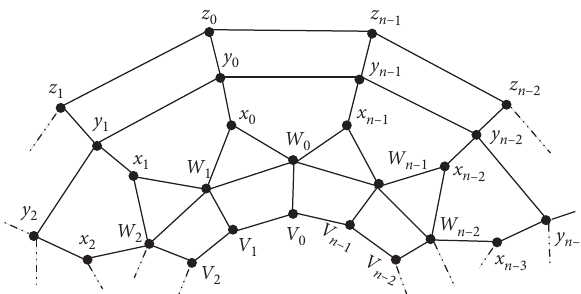
Figure 4: The graph of convex polytope B